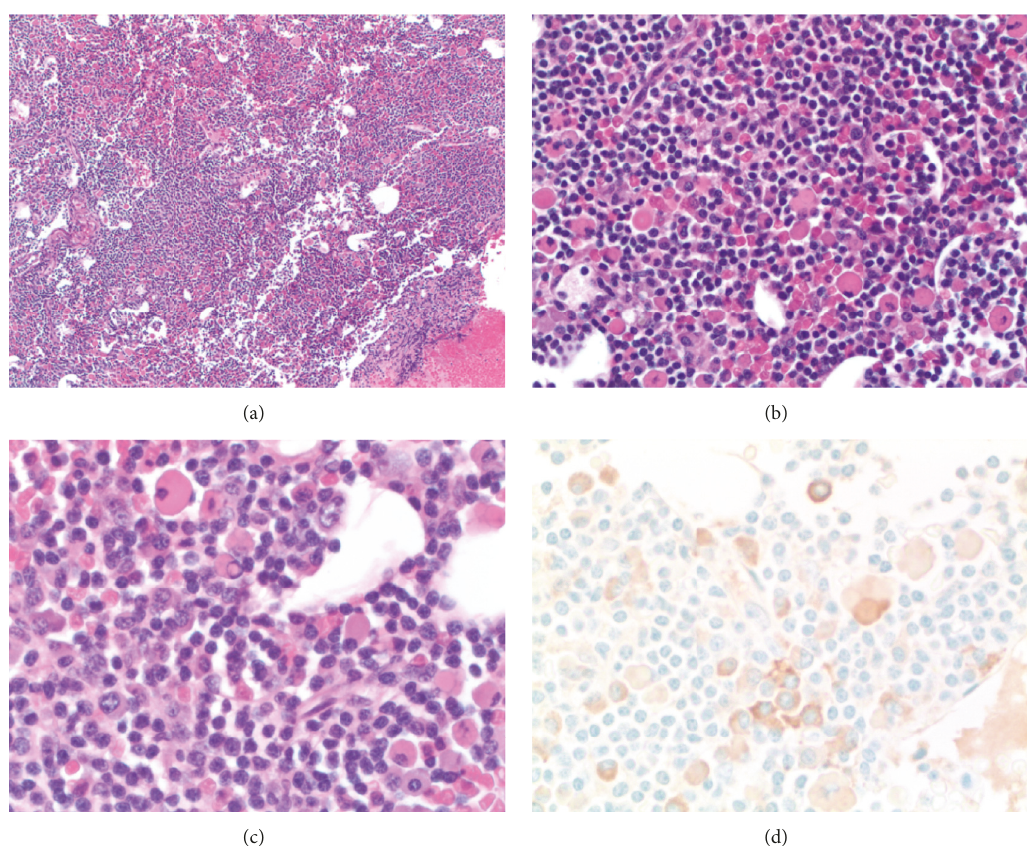
Figure 2: Lymphoplasmacytic lymphoma, H&E (a). Plasma cells with Dutcher bodies (b). Lymphocytes and plasma cells with Dutcher bodies and Russell bodies (c). Kappa light chain stain